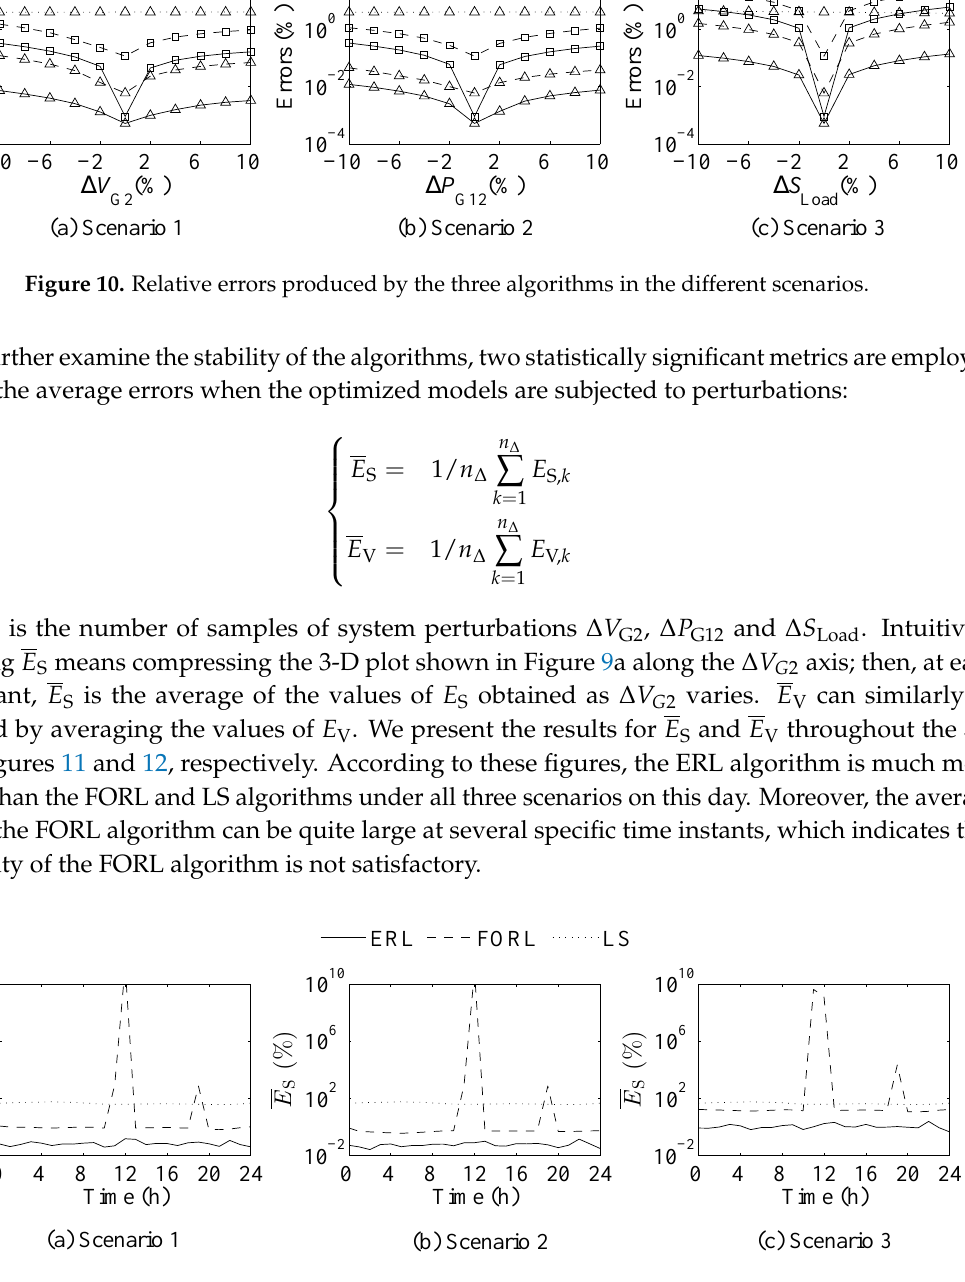
Figure 11. Mean complex power errors produced by the three algorithms in the different